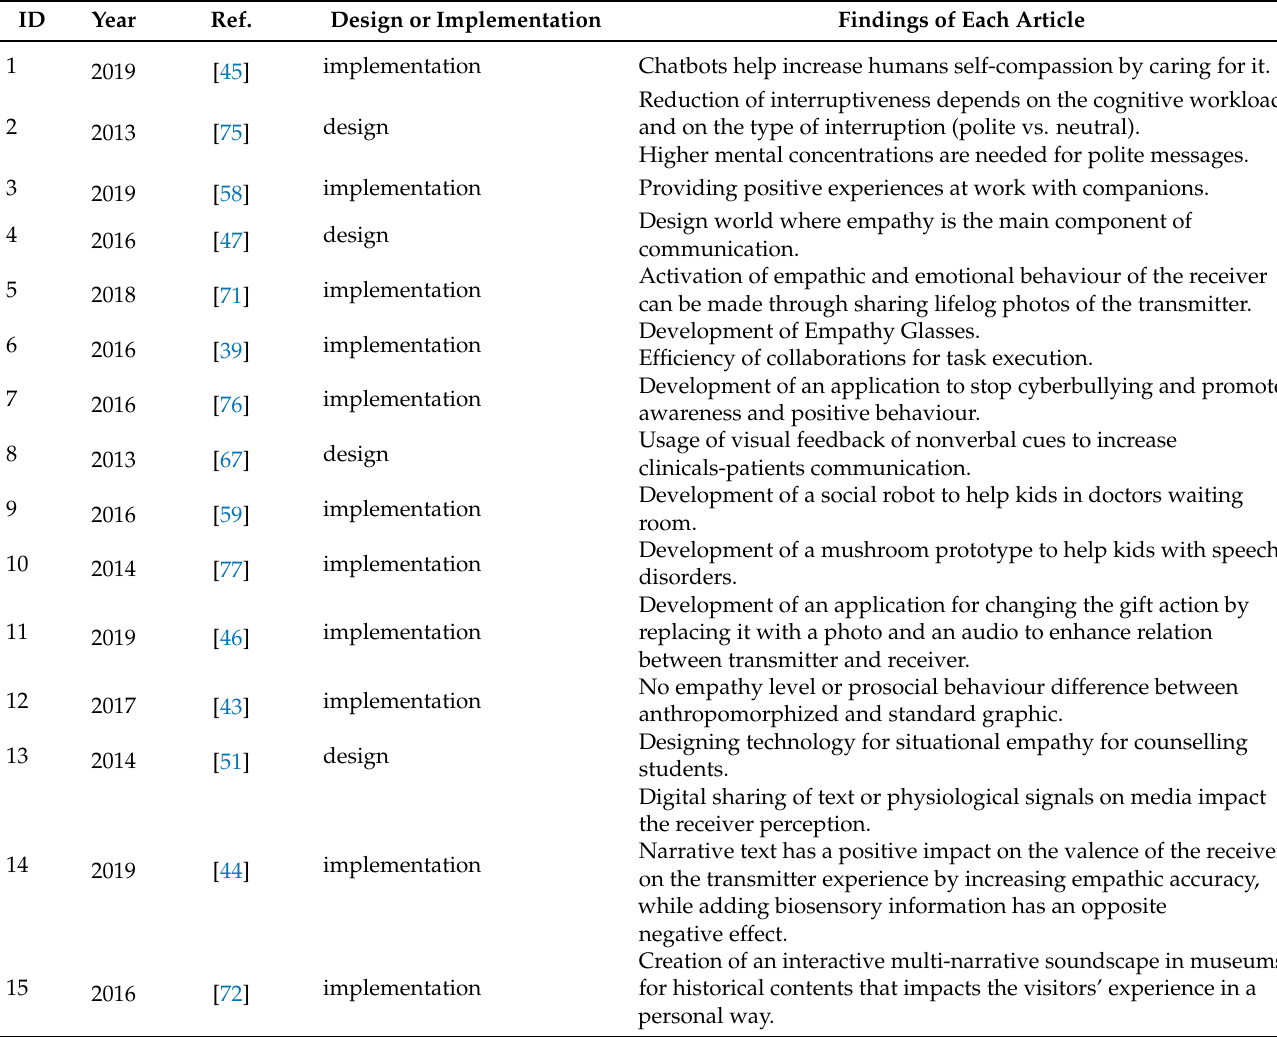
Table 2. Article Detail Data Sheets of 59 papers including the ID, year, design or implementation, and the findings of each of the